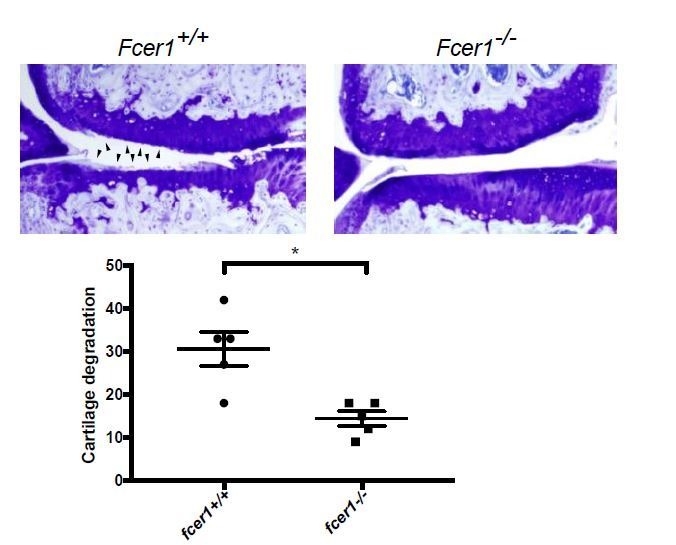
Fcer1-deficient mice are protected against the medial meniscectomy (MM) model of osteoarthritis.Representative toluidine blue stained medial stifle joint sections from Fcer1-deficient (Fcer1-/-) and wild-type (Fcer1+/+) mice; arrowheads show areas severe cartilage loss (upper panels). Quantification of cartilage degeneration in the medial regions of stifle joints from these mice (lower panel).